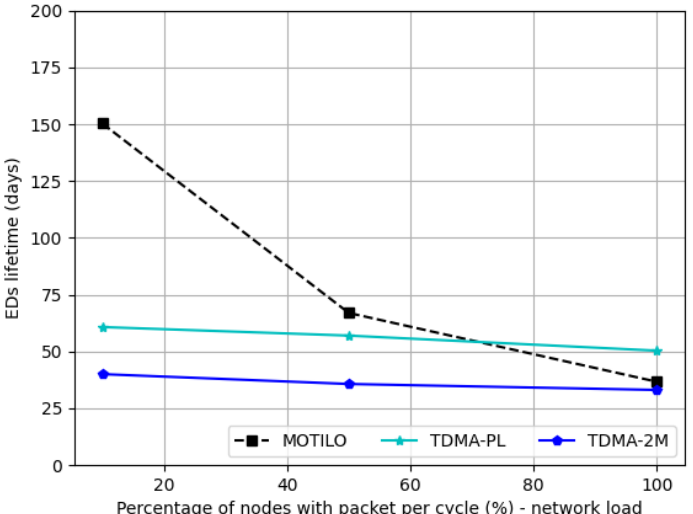
Figure 8. Energy evaluation of TDMA-PL, TDMA-2M and MOTILO algorithms for 9